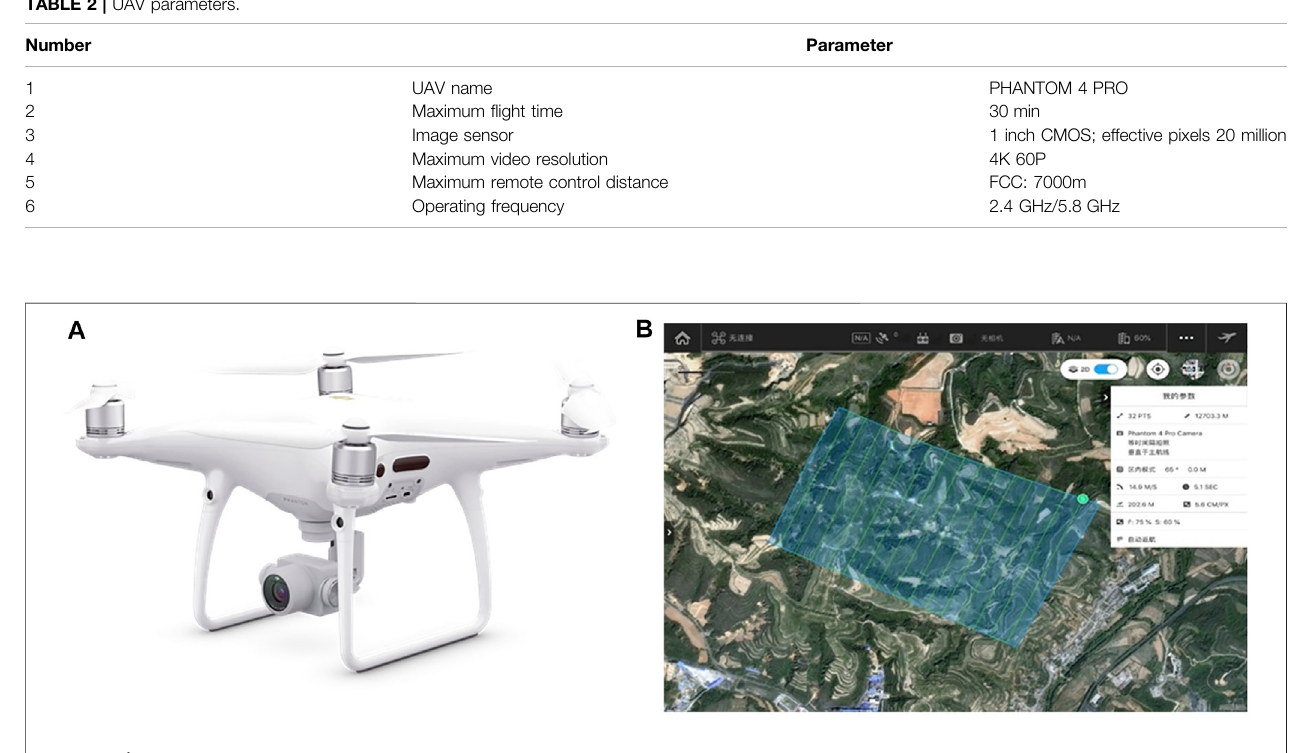
FIGURE 2 | Route design. (A) UAV. (B) Route